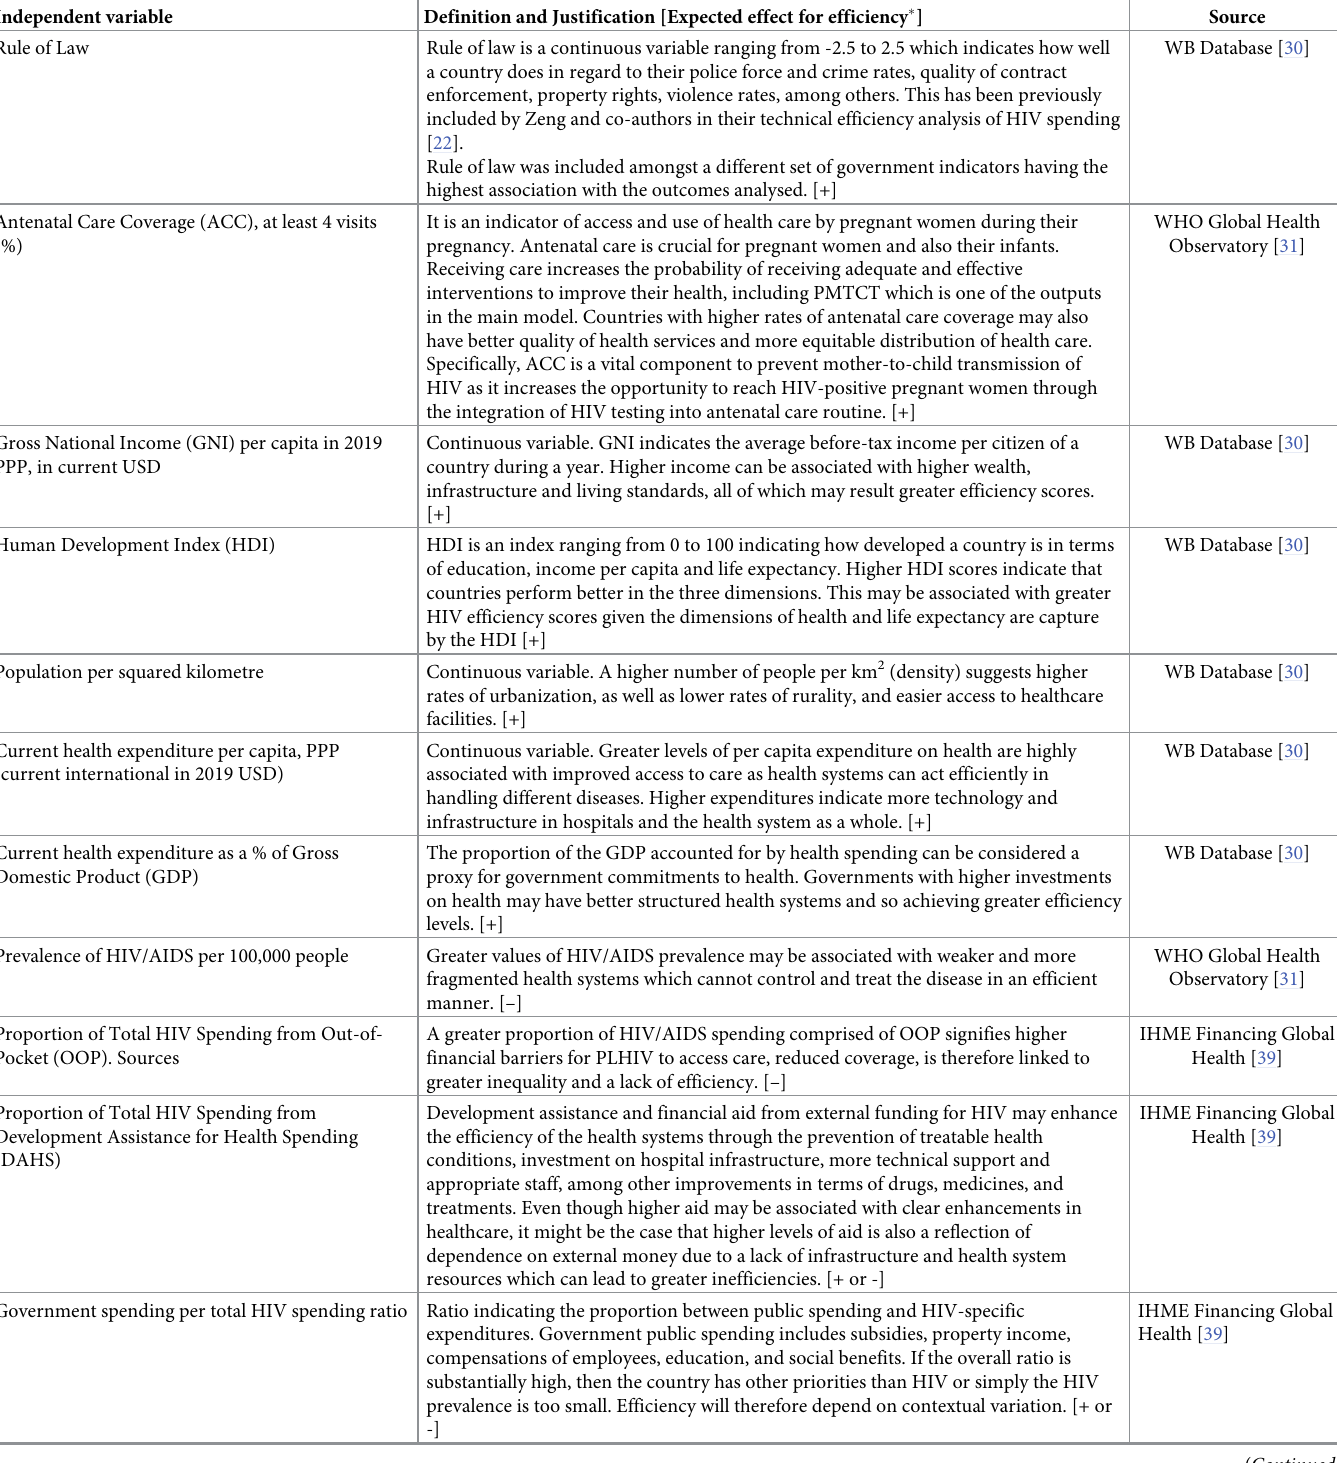
Table 2. Expected effect of independent variables on technical efficiency and justification for inclusion in the